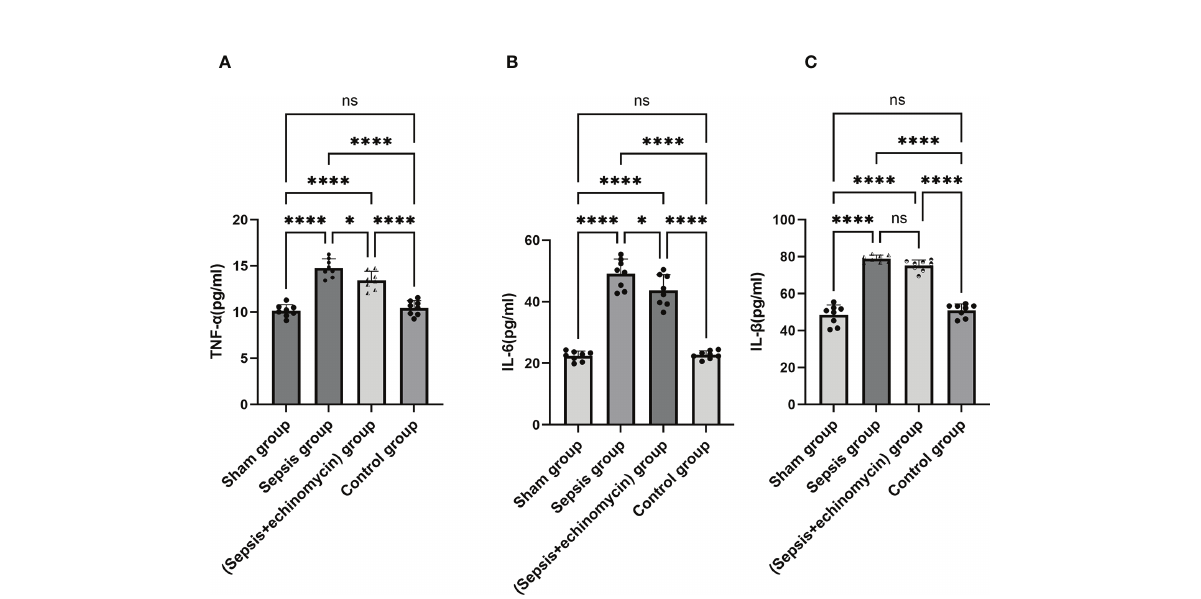
FIGURE 11 The HIF-1 a and BNIP3L pathway induced immune response. (A) : TNF- a protein expression in hippocampus; (B) : IL-6 protein expression in hippocampus; (C) : IL- b protein expression in hippocampus; Sepsis induce the IL-6, IL- b , TNF- a protein expression of hippocampus, TNF- a and IL-6 expression were signi fi cantly reduced after administration of HIF-1 a inhibitor.*: p < 0.05, ****: p < 0.0001, ns: p >